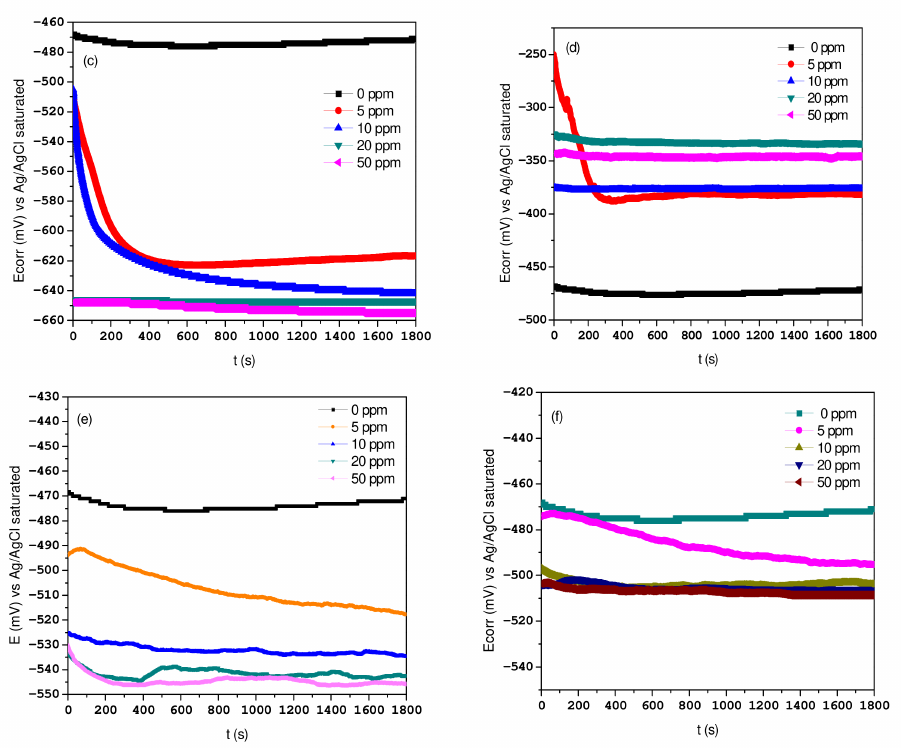
Figure 1. OCP plots at different concentrations of ( a ) compound 3a , ( b ) compound 3b , ( c ) compound 3c , ( d ) compound 3d , ( e ) compound 3e , and ( f ) compound 3f immersed in HCl 1